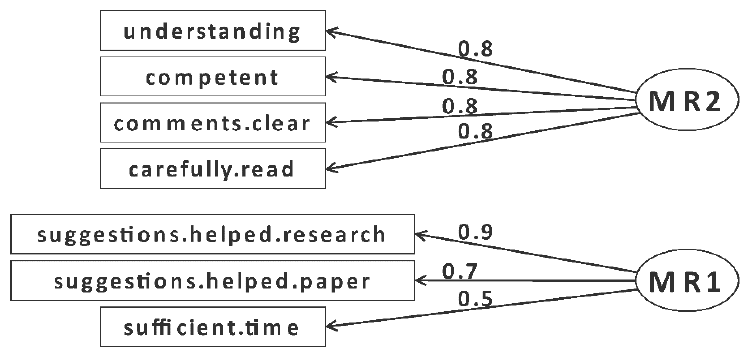
Figure 2. Factor loadings in the analysis on the variables reflecting the authors’ assessment of the reviewers.